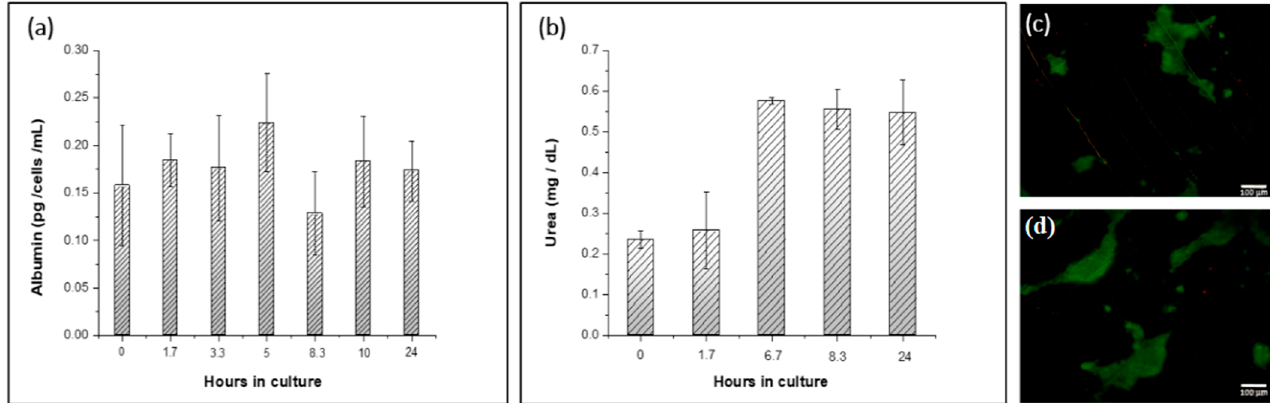
Figure 5. ( a ) Albumin secretion rates generated by a hybrid cyclic olefin copolymer–polydimethylsiloxane (HCP) microfluidic platform applied for Huh7 hepatoma cell line culture under perfusion; ( b ) Secretion rate of urea collected in eluent fractions from the HCP over 24 h at 37 °C; ( c , d ) Live-dead assay imaging results from HCP device with 1 mm thickness of PDMS layer. Green (Calcein-AM)—live cells, red (Propidium Iodide)—dead cells (no autofluorescence from the substrate).